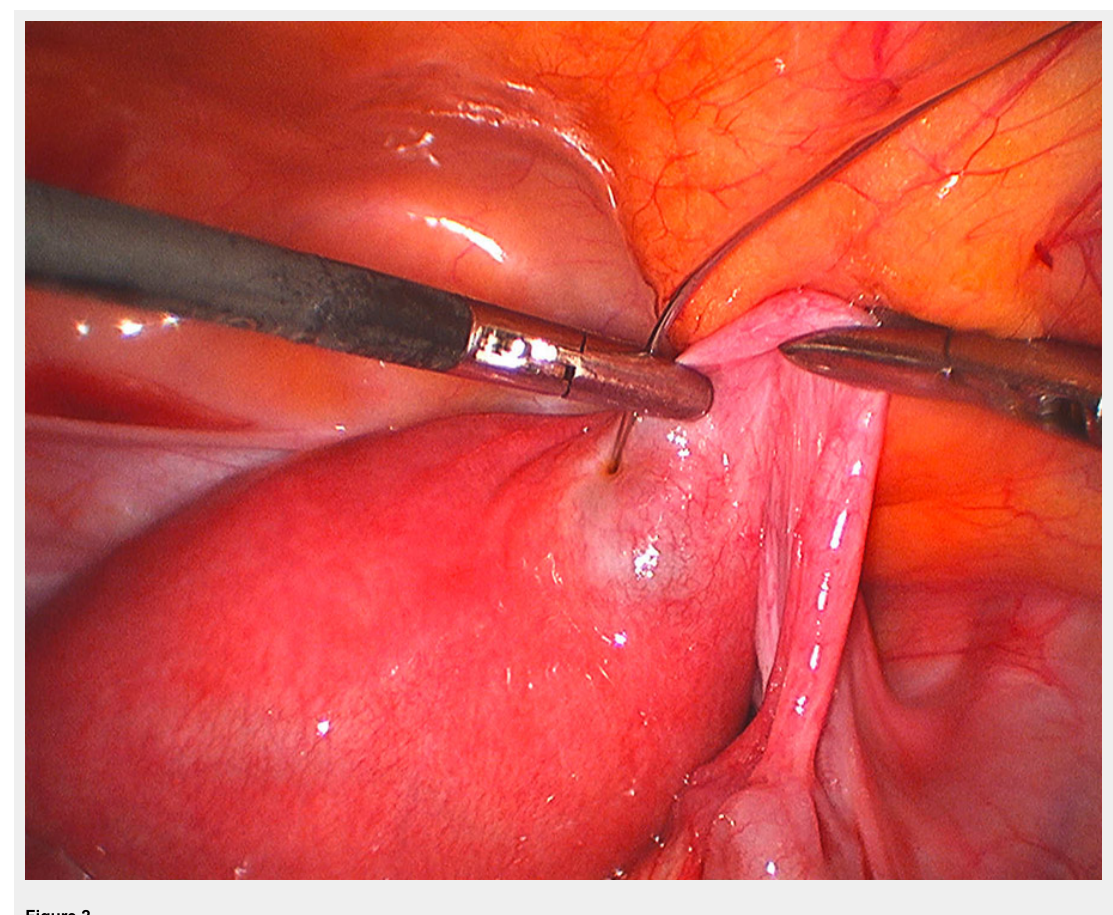
Figure 2 Laparoscopic intracornual MTX